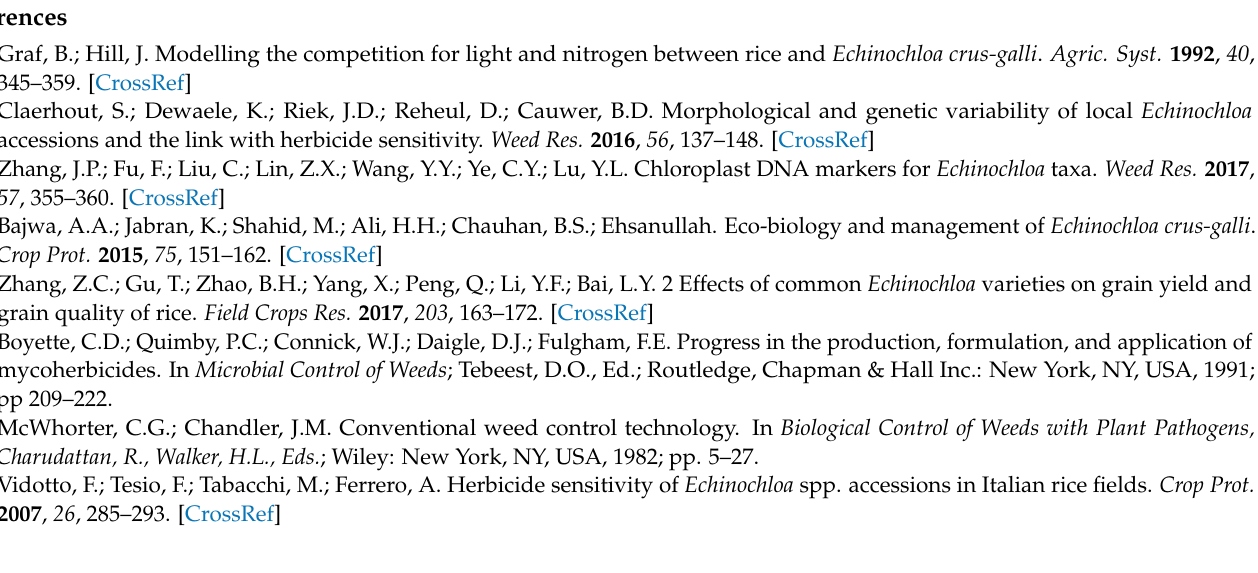
Table 3 through regression analysis. The treatment means in Tables 1 and 2, after uniformly normalizing to positive decimals, then square root, and arcsin transformation to normalize the variance, were compared by Tukey’s multiple range tests at a 5% level of significance. The treatment means of the percentage of the reduction rate in Tables 4 and 5 were compared by Duncan’s multiple range tests at a 5% level of significance after the same conversion. The results were back-transformed to the original ratings for presentation. The statistical analyses for the rice yield in Tables 4 and 5 were performed without